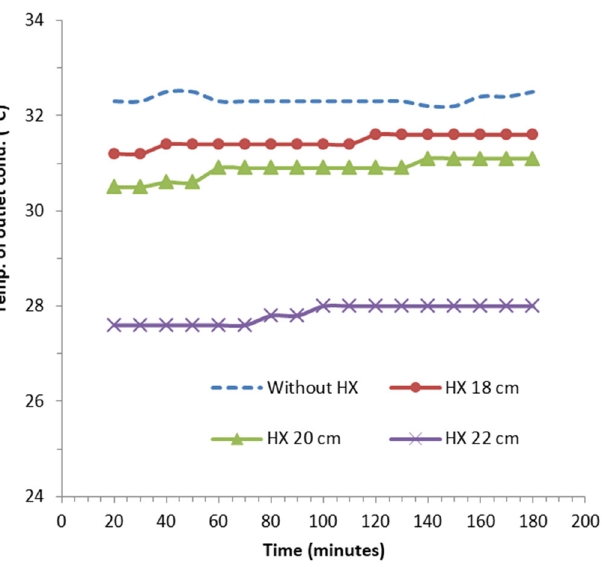
Figure 4. Temperature of outlet condenser of air conditioner without and with condensate water as a subcooler at three different lengths of heat exchanger.